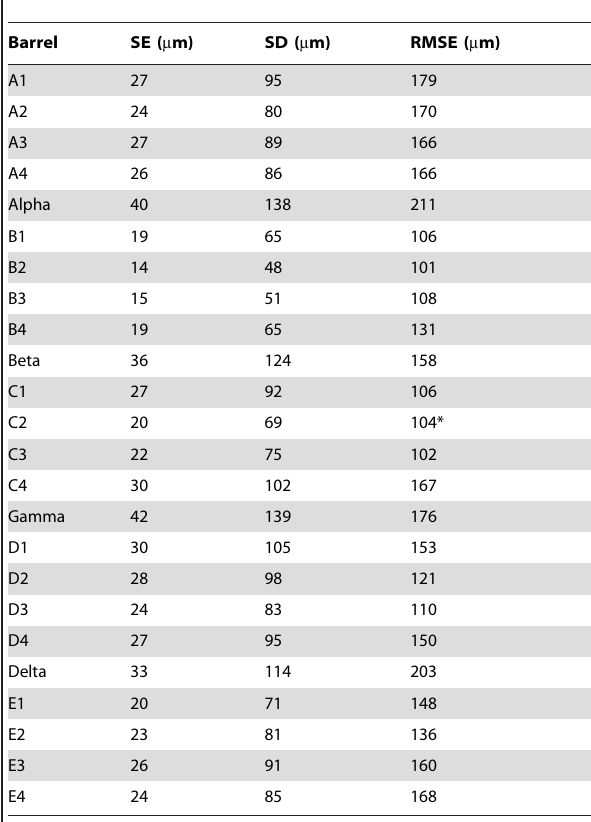
Table 2. Precision of registration for each barrel column.